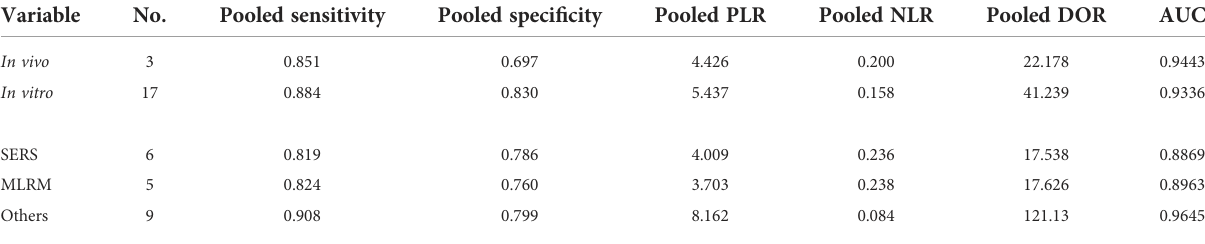
TABLE 3 Pooled diagnostic value of subgroup analysis.